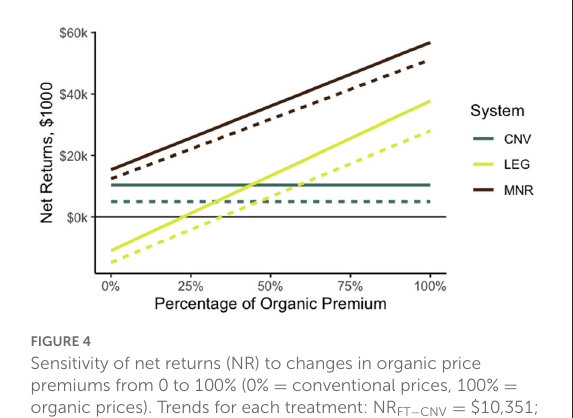
FIGURE4 Sensitivity of net returns (NR) to changes in organic price premiums from 0 to 100% (0% = conventional prices, 100% = organic prices). Trends for each treatment: NR FT − CNV = $10,351; NR RT − CNV = $4,950; NR FT − LEG = –$11,020 + $48,753[%]; NR RT − LEG = –$14,828 + $42,858[%]; NR FT − MNR = $15,350 + $41,416[%]; NR RT − MNR = $12,369 +